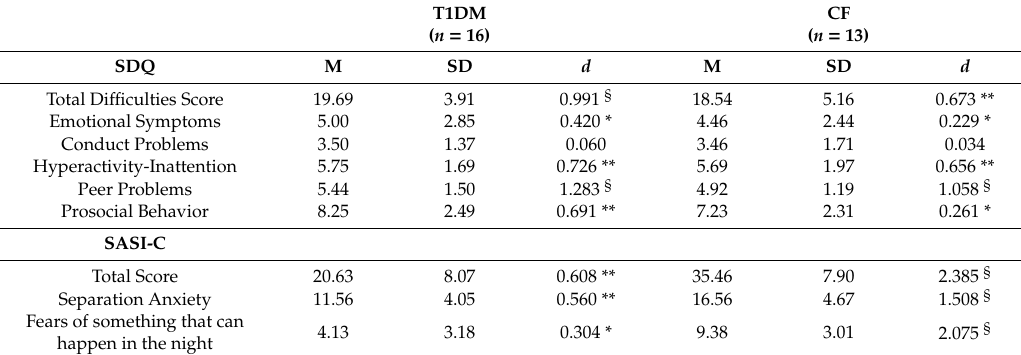
Table 2. Cohen’s d for T1DM and CF groups in comparison with normative sample.